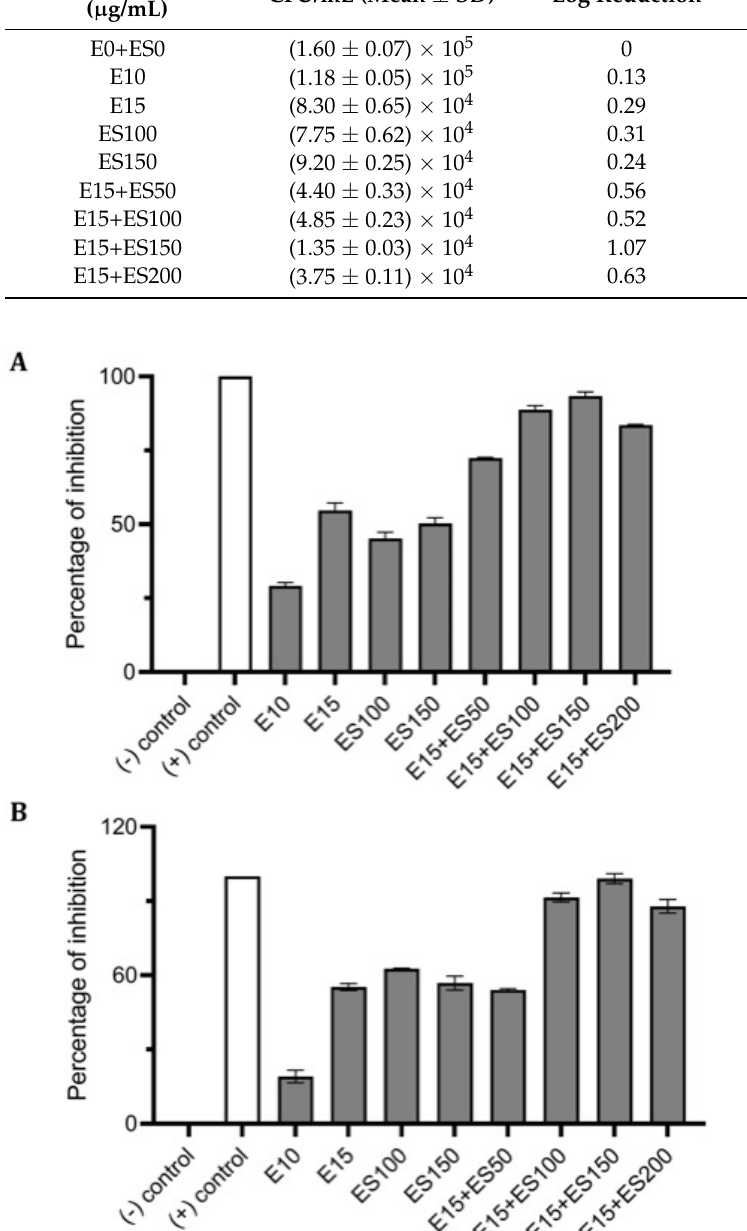
Table 2. Colony-forming units (CFU/mL) and respective log reduction and percentage of inhibition for different treatments on biofilm formation in M. smegmatis . E: erythromycin; ES: EGCG-S. Treatments